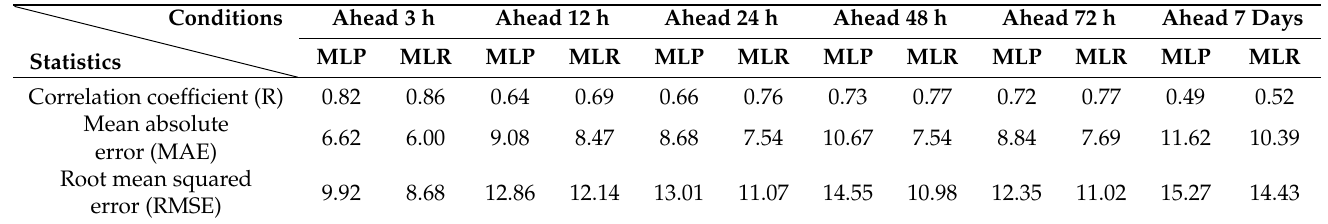
Table 3. Statistical results of the assessment of the accuracy of multilayer perceptron (MLP) and multiple linear regression (MLR) models.